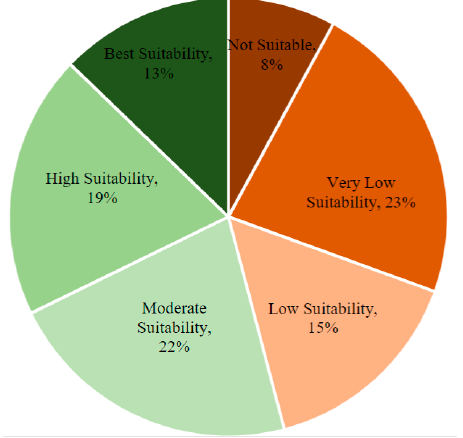
Figure 8. Distribution of suitable land in Cambodia for water harvesting.